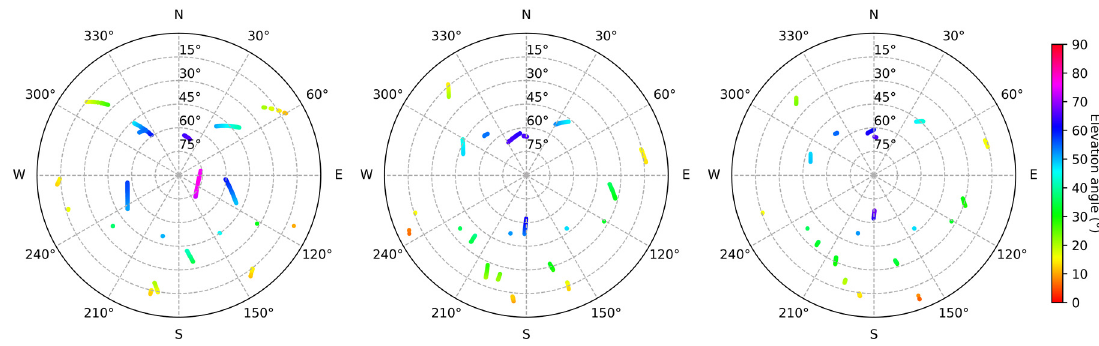
Figure 4. Skyplots of GNSS observations. The diagrams from left to right correspond to D1, D2, and D3, respectively.